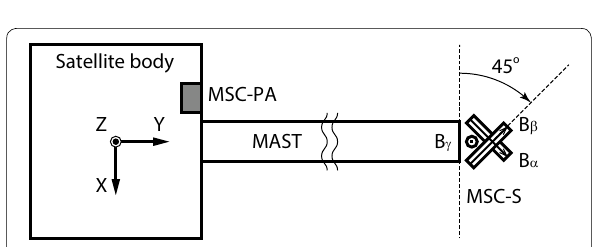
Fig. 2 The αβγ coordinates for the MSC in the SGA coordinates. The γ axis is parallel to the satellite spin axis, and the α – β plane is in the satellite spin plane